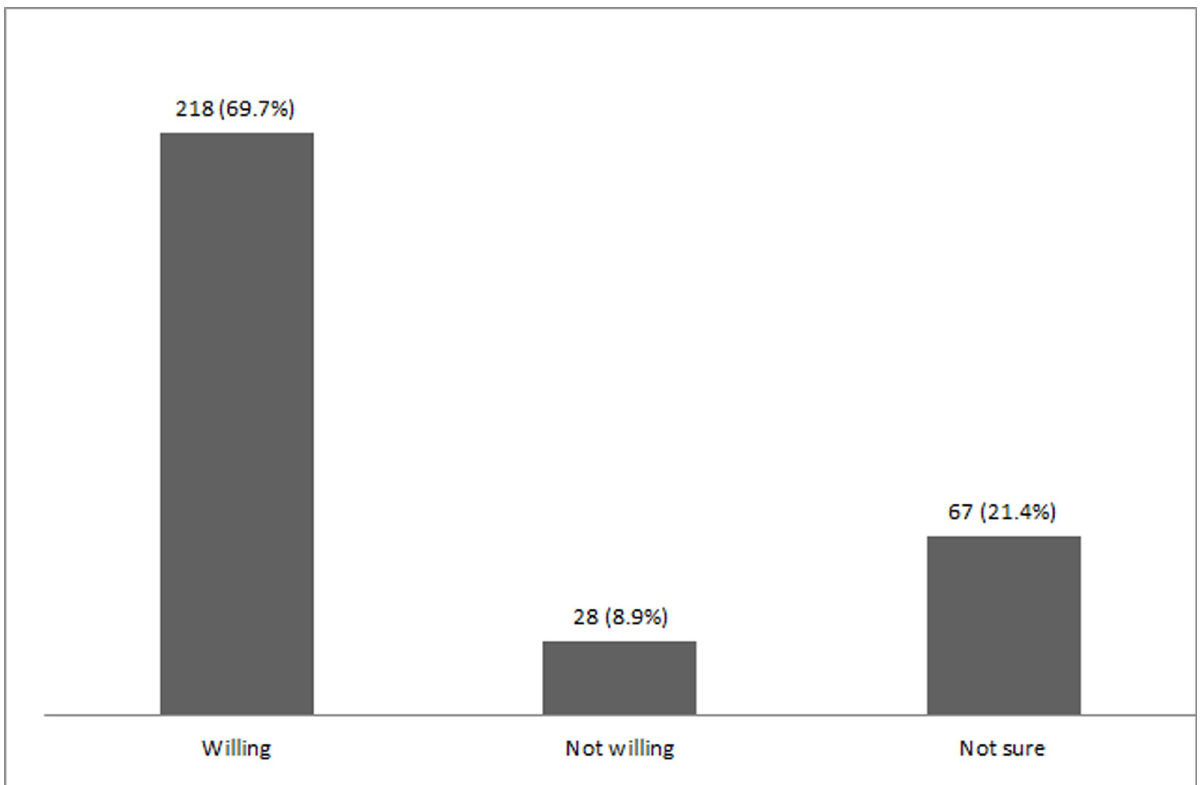
Fig 1. Willingness of the physicians to work during COVID-19 pandemic (n =